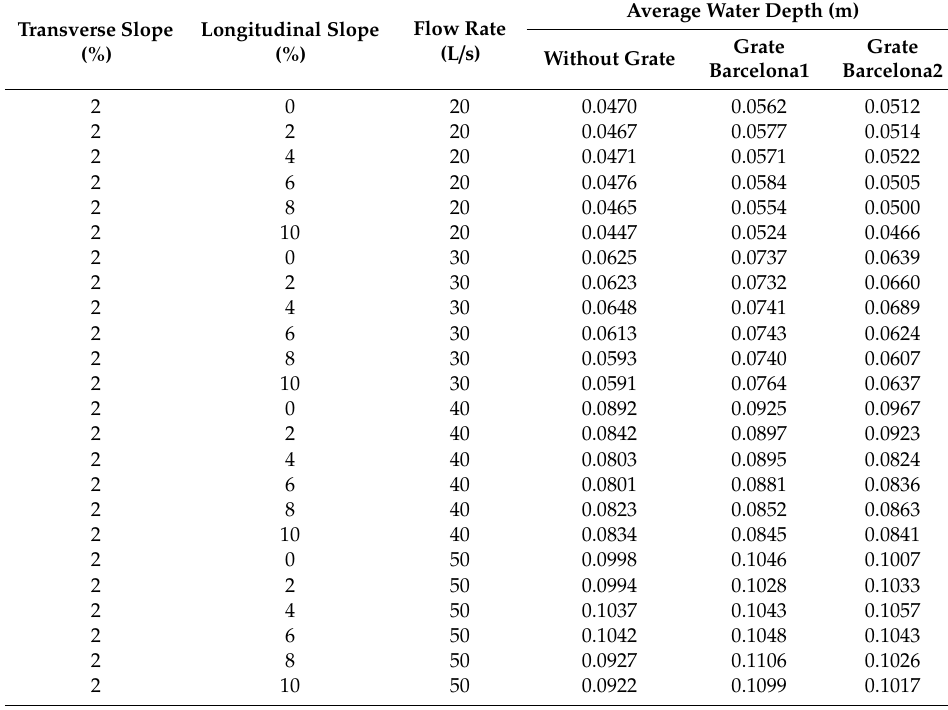
Table A1. Average water depths of the 20 points above the surcharged